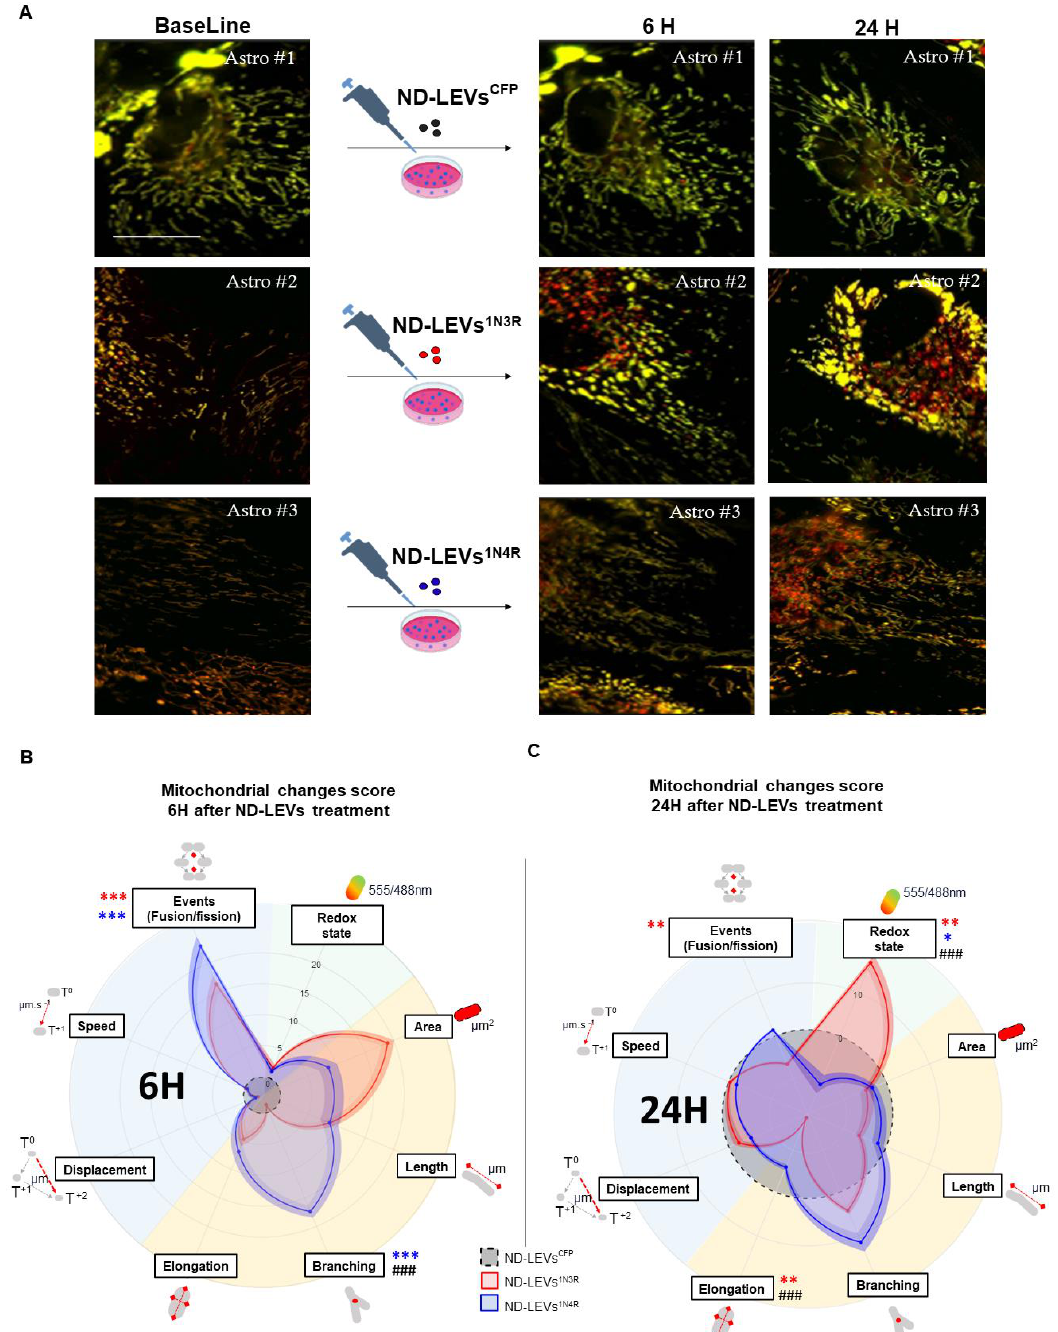
Figure 4. Tau isoform-containing LEVs induce mitochondrial dysfunction in primary rat astrocytes. ( A ) Micrographs of the mitochondria labeled with the biosensor MitoTimer before (BL) and after (6 h and 24 h) treatment with ND-LEVs CFP , ND-LEVs 1N3R , and ND-LEVs 1N4R . ( B , C ) Radar charts showing MitoTimer ratio 555/488nm, morphology (surface area, length, number of branches, factor of elongation,), mobility (displacement and speed), and number of event changes (fusion/fission), normalized to BL values and the value of the ND-LEV CFP group, in astrocytes treated with ND- LEVs 1N3R and ND-LEVs 1N4R . Two-way matched ANOVA followed by post hoc analysis (Tukey’s test) was applied to compare the effect of each treatment with that of ND-LEVs CFP (* p < 0.05, ** p < 0.01 and *** p < 0.001). A multiple t test was performed on each criterion between ND-LEVs 1N3R and ND-LEVs 1N4R to evaluate the difference in effect between the 3R and 4R isoforms ### p <